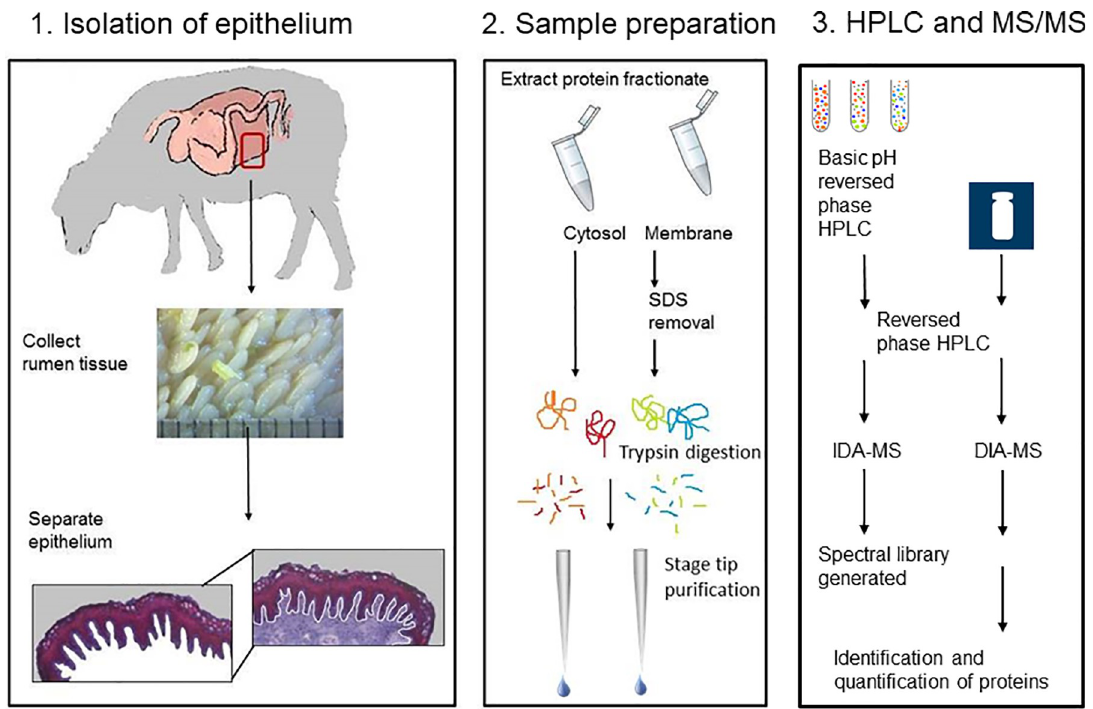
Fig 1. Workflow of the epithelium proteome analysis 1). Whole depth rumen tissue (n = 20) were collected, treated with enzyme and the epithelium isolated by microdissection. 2). Sample preparation; Each epithelial tissue sample was homogenised and fractionated into a cytosol and membrane fraction (n = 20/fraction), the protein extracts dialysed and SDS removed prior to trypsin digestion. 3). High pH (HpH) fractionation by HPLC, followed by LC-MS/MS analysis of the peptides in Independent Data Acquisition (IDA-MS) mode. 4) Data-Independent Acquisition-MS (DIA-MS) analysis of individual samples using SWATH-MS procedure for label-free quantification. Protein identifications were made using Ensembl ovine database. extracted from the SWATH data using a maximum number of peptides of 100, 75 ppm mass tolerance, peptide confidence threshold of � 0.99, and a 5 min retention time extraction win- dow. After data processing, peptides with confidence > 99% and FDR < 1% (based on chro- matographic feature after fragment extraction) were used for quantitation. The extracted peak areas were exported into Excel for further statistical analysis. Differentially expressed proteins were determined by pairwise comparisons of pairs of samples using t-tests on log-transformed normalized protein peak areas; peptide level t-tests were also carried out [15]. Proteins were deemed to be differentially expressed if the ANOVA p value was less than 0.05, and the protein fold change exceeded 1.5 [16, 17]. Proteins identified with 1 or more peptides were retained in the proteins accepted with differential abundance capable of discriminating between pheno- typic group for CH emission. The workflow described in the above steps are summarised in 4 Fig 1. The search results are available at proteomics identification database PRIDE (https:// www.ebi.ac.uk/pride/archive/, PRIDE ID: PXD026538) and S1 Table. Phenotypic trait data were analyzed using a general linear model (www.minitab.com; v18) [18]. Variable effects tested were CH , CO , MY, rumen volume, N and C balance, DMD, 4 2 MRT with fixed effects of experimental test period (n = 4 data taken from incomplete block design experiment) and phenotype (L or H CH ) adjusted for covariable effects of DMI and 4 liveweight. Rumen fluid metabolite and blood metabolite data were analysed using a general linear model with metabolite as variable effect and fixed effect of phenotype adjusted for a cov- ariable effect of liveweight.